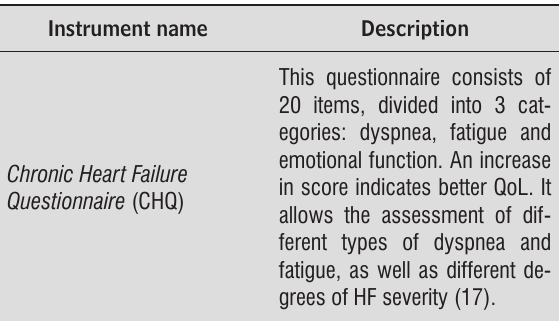
Table 1 - Summary and description of the question- naires found in the literature